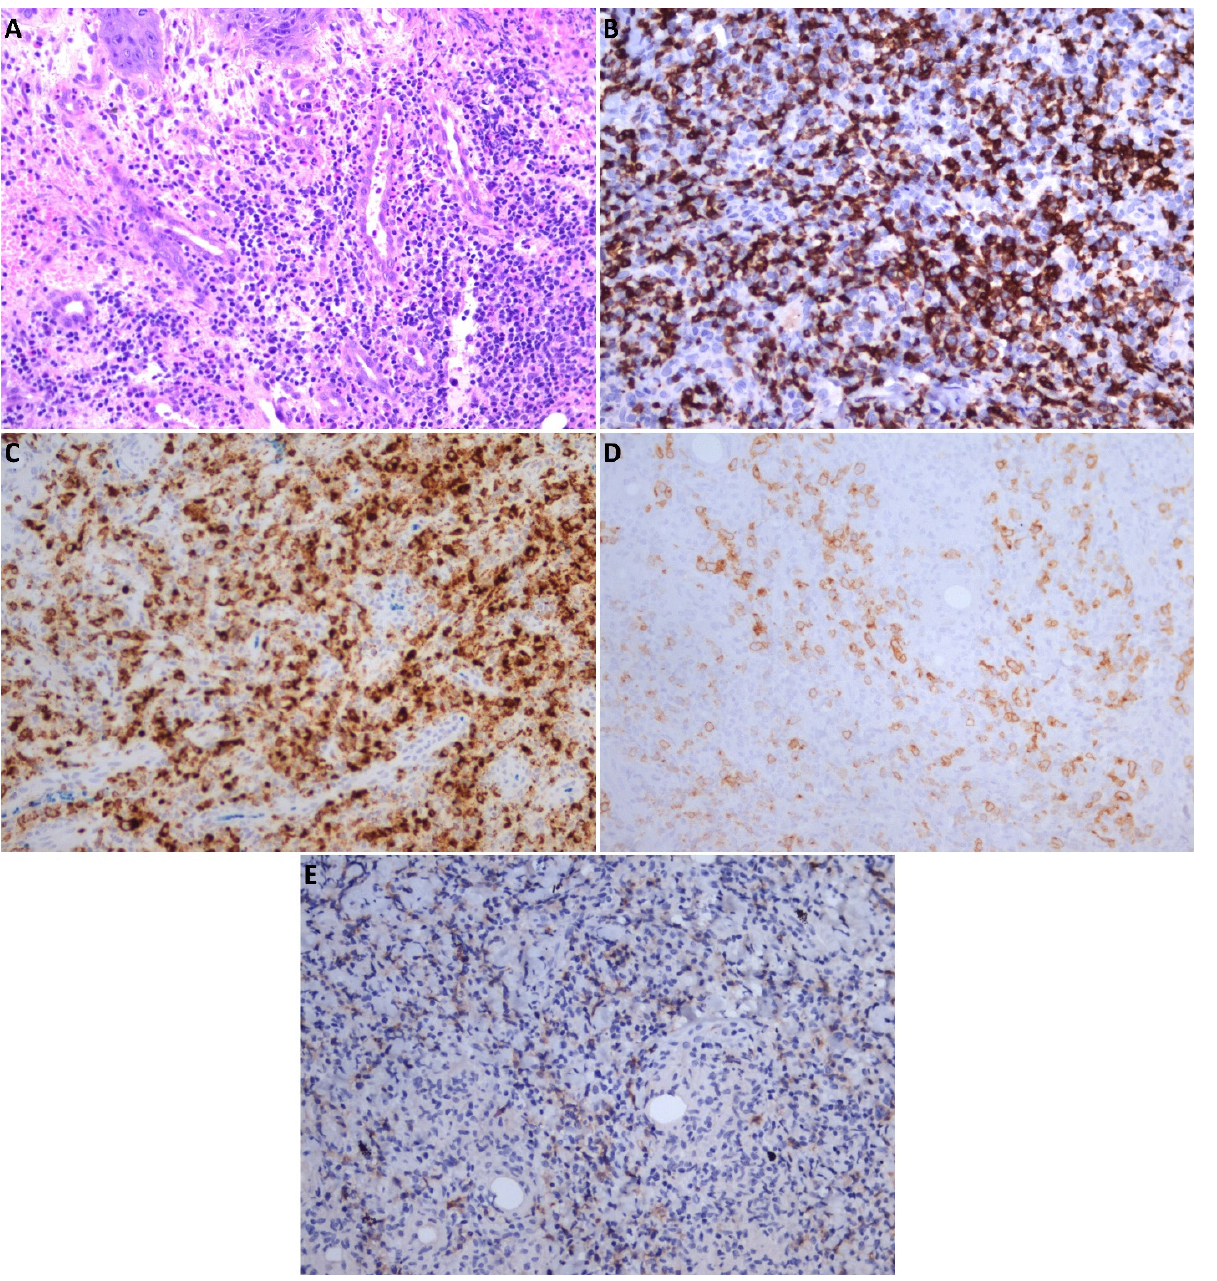
Figure 4. Histopathology and immunohistochemistry assessments: ( A ) polymorphous lymphoid infiltrate in the epithelium, with small- or medium-sized cells, with incised or angulated nuclei and moderate cytoplasm, HE, original magnification ×20; ( B ) diffuse positive staining for CD3 in T cells, original magnification ×20; ( C ) diffuse positive staining for granzyme B (a marker for cytotoxic activation), original magnification ×20; ( D ) positive staining for CD30 (a marker for activated lymphocytes), original magnification ×20; ( E ) cells with low-intensity staining for CD56 (a marker for NK cells), original magnification ×20.